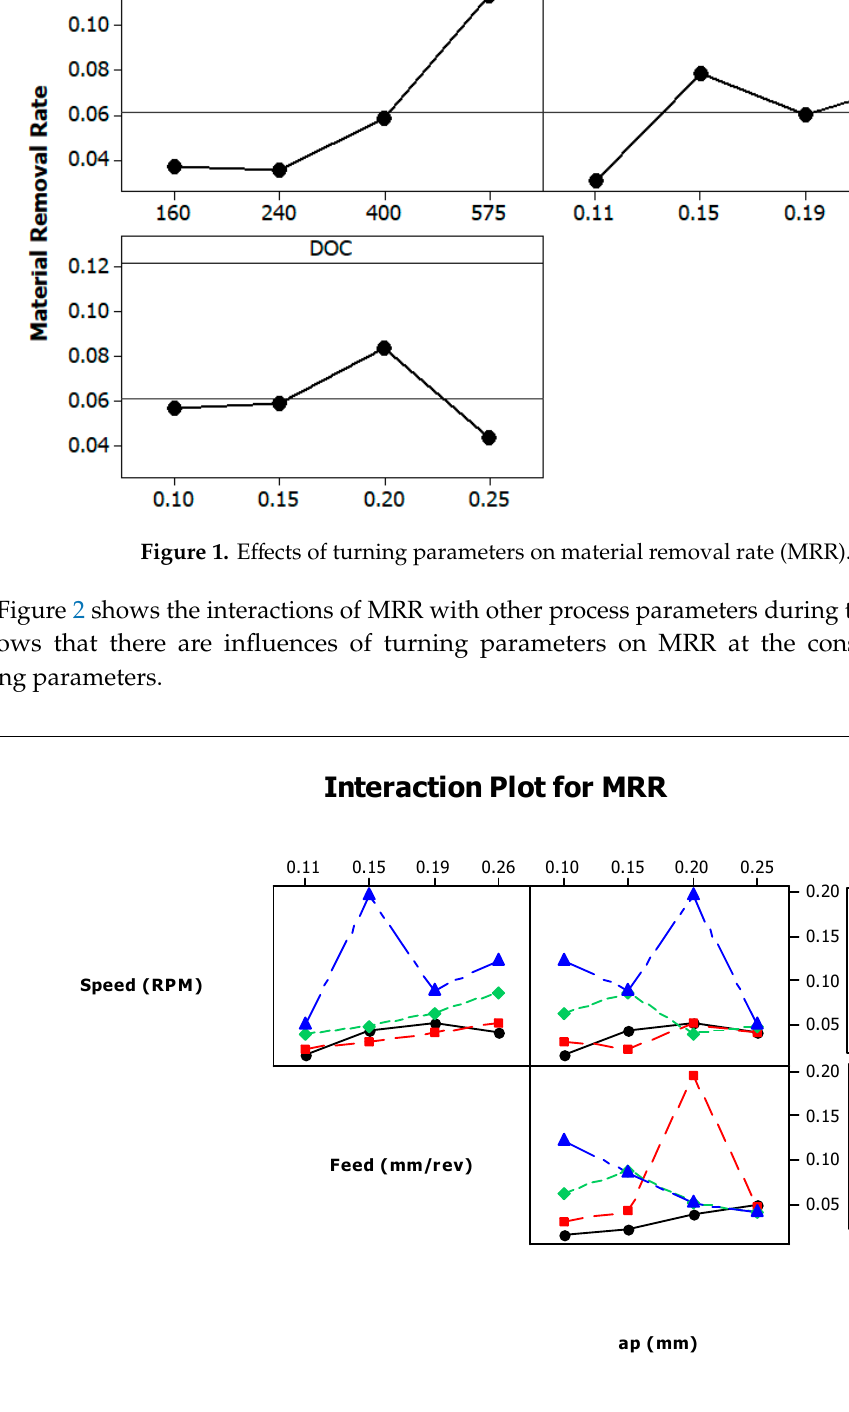
Table 4. Analysis of variance for material removal rate (MRR).